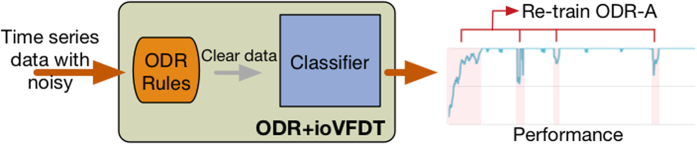
ODR-R-ioVFDT Model.